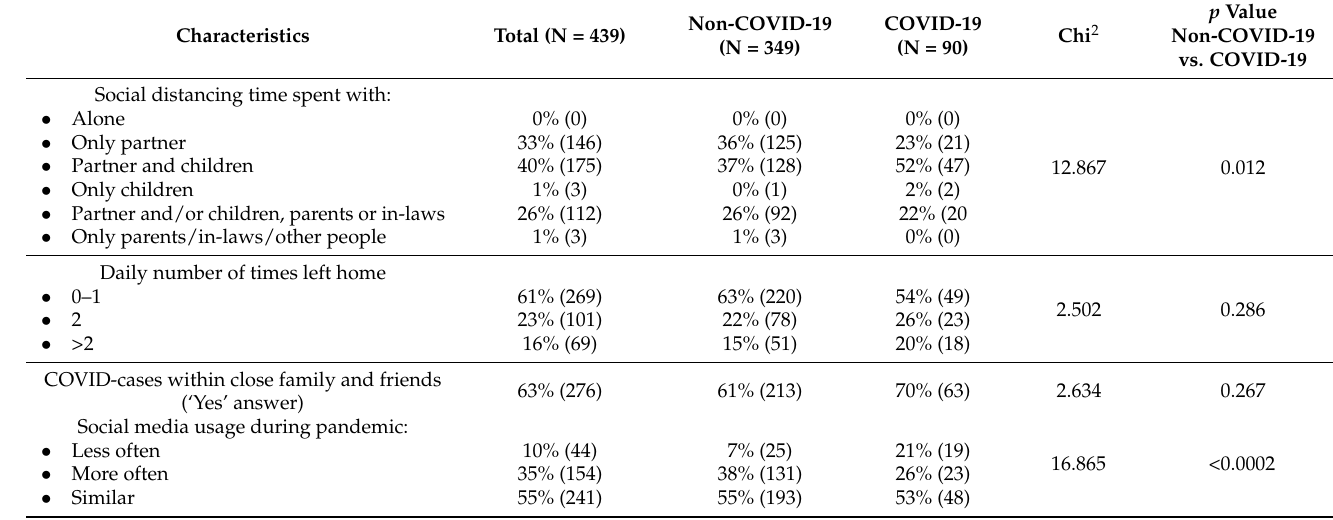
Table 3. Daily life measures during the COVID-19 pandemic.